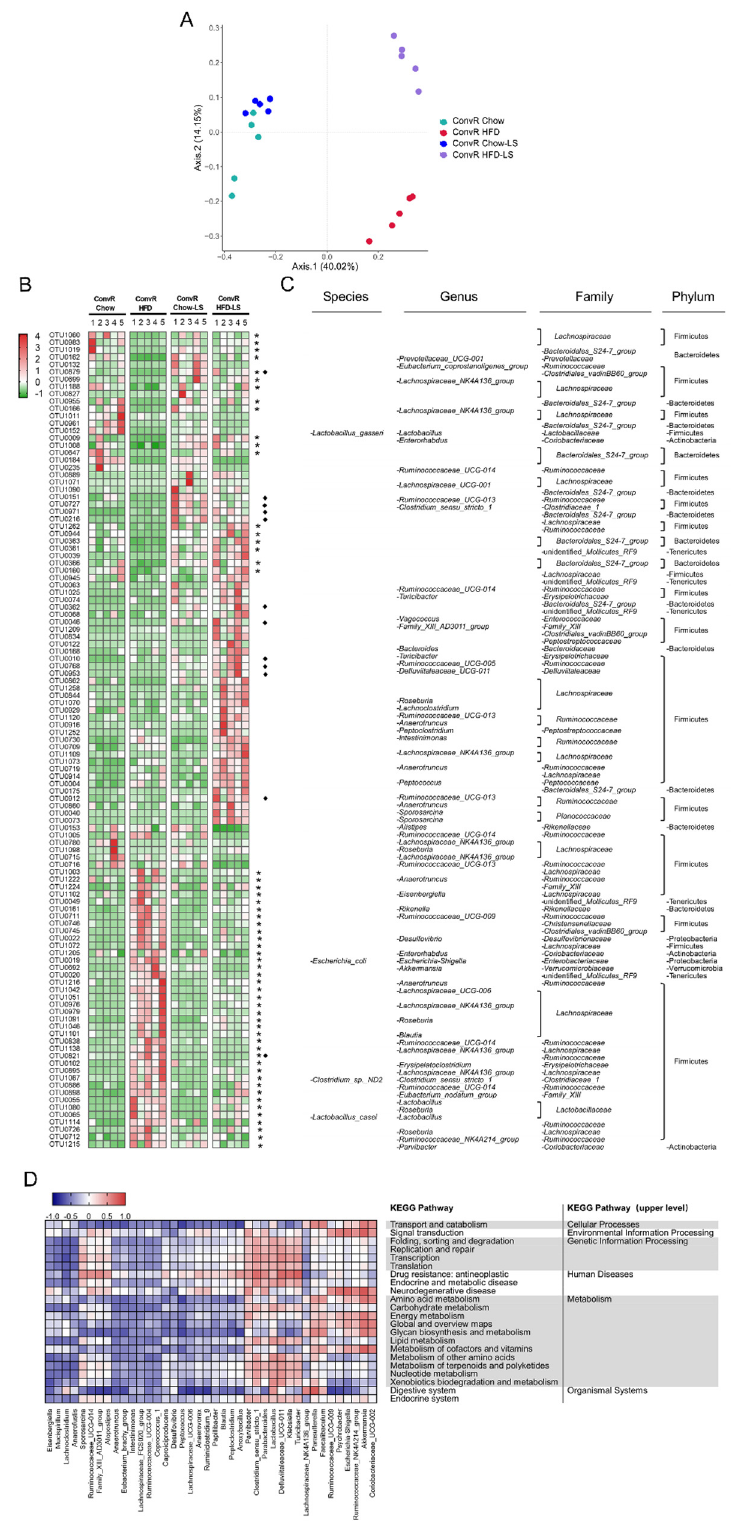
Figure 3. LS alters microbiota composition in HFD-fed mice. ( A ) Principal coordinate analysis (PCoA) plot based on the Bray–Curtis distance OTU matrix of mouse colon microbiota in ConvR Chow, ConvR Chow-LS, ConvR HFD, and ConvR HFD-LS groups. ( B ) Heatmap showing the abundance of 111 OTUs significantly altered by LS in HFD-fed mice based on Metastats analysis.